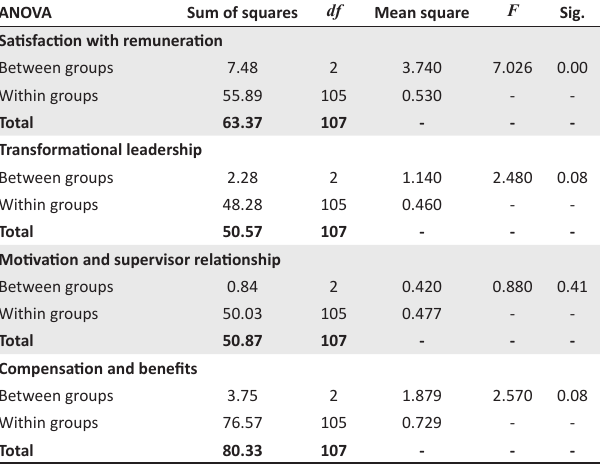
TABLE 2: Analysis of variance comparison – between and within groups of motor (diesel) mechanics, auto electricians, welders or refrigerator mechanics or carpenters as well as other trades.